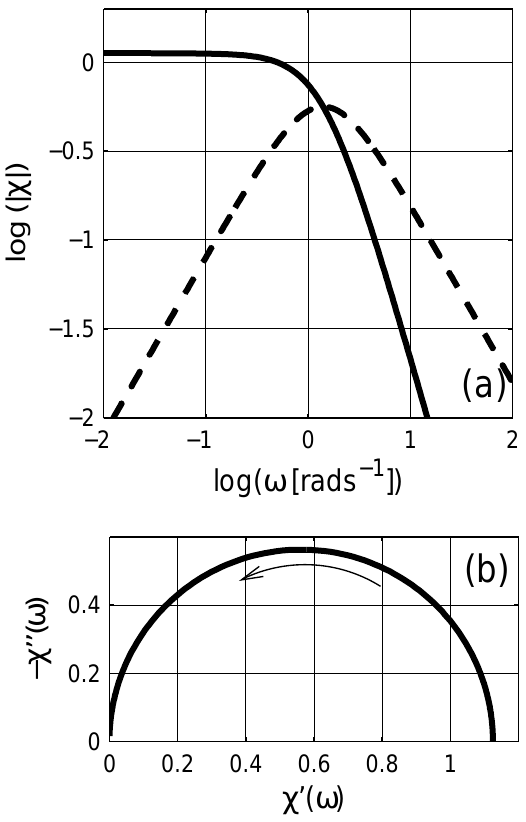
Figure 2 . (a) Dielectric susceptibility χ as a function of angular frequency ω ; the real and the imaginary parts are presented with solid (——–) and dashed (– – –) lines, respectively. The arrow indicates the direction of increasing angular frequency ω . (b) The Argand diagram (Cole-Cole plot) of susceptibility. Logarithmic scale is base